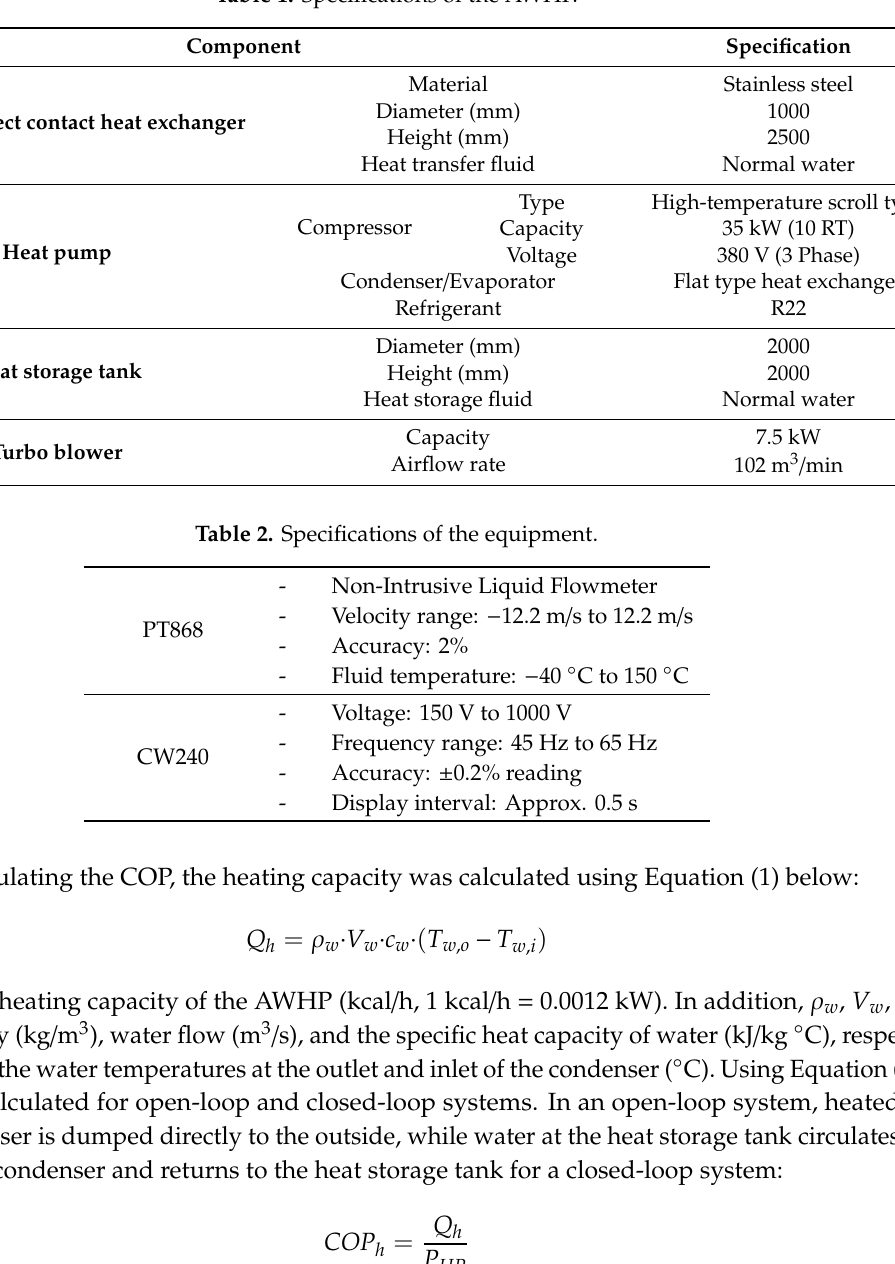
Table 1. Specifications of the AWHP.